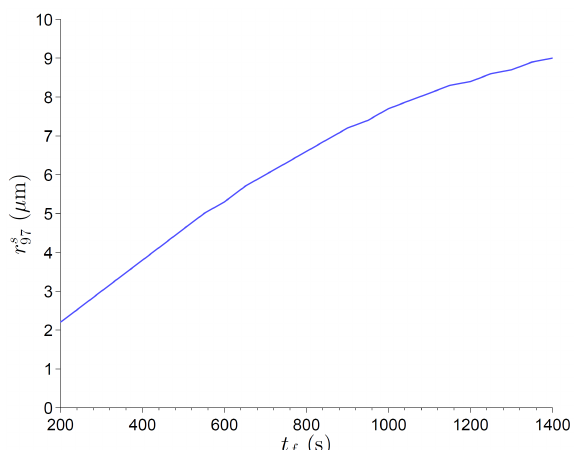
Figure 8. Influence of the solidification time on the size of largest inclusions in the solid phase. ( ω N = 10 ppm, oxide density = 10 11 m − 3